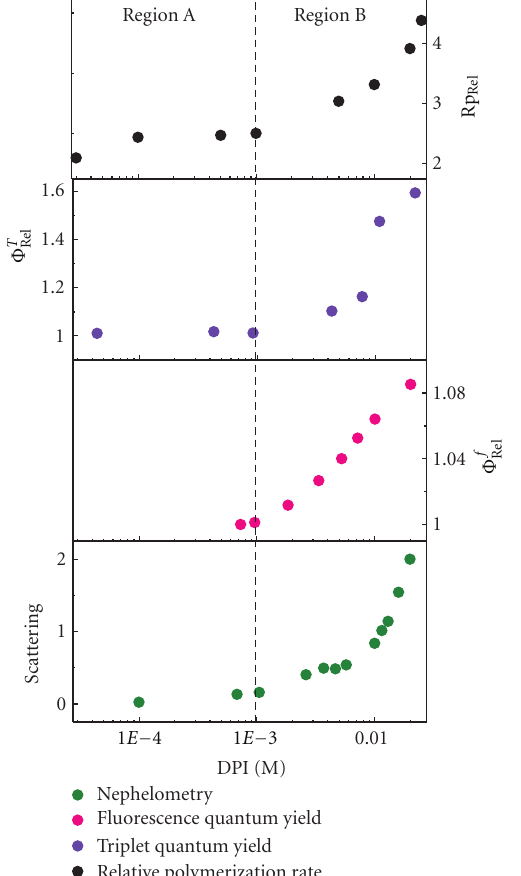
Figure 7: E ff ect of DPI concentration on the scattering as measured by nephelometry ( ), fluoresence quantum yield ( ), triplet quantum yield ( ) and relative polymerization rate ( ). All measurements in water are at 25 ◦